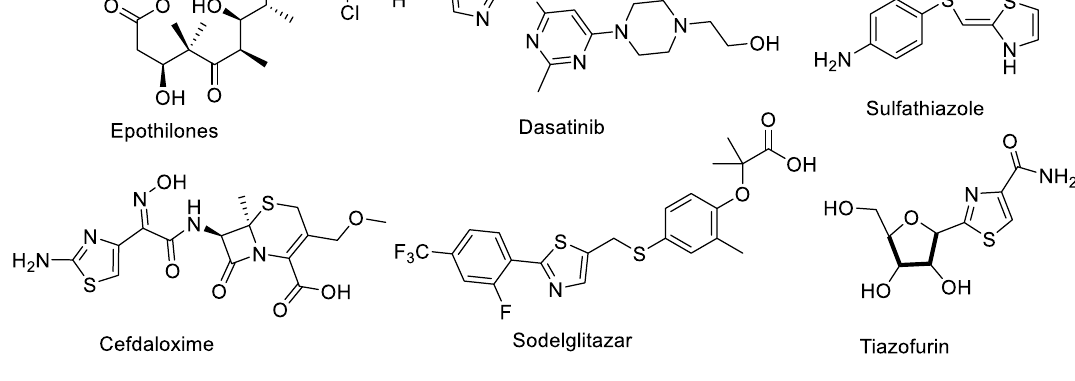
Figure 1. Commercial drugs contain thiazole moiety.